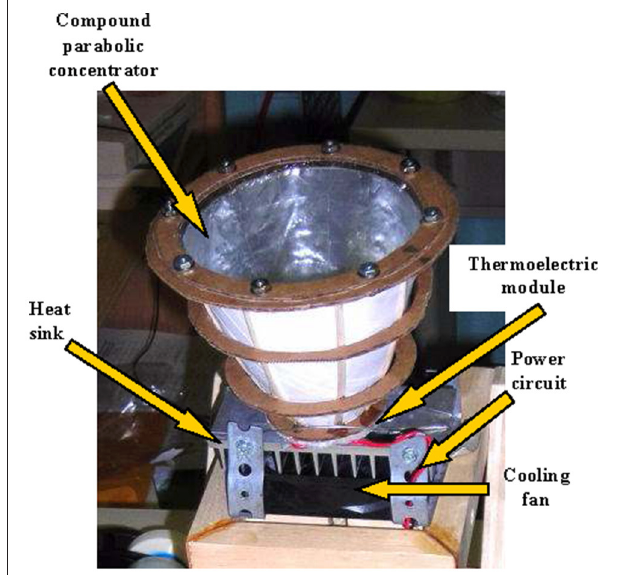
FIGURE 2 | The experimental set-up showing the interior of the manually fabricated compound parabolic